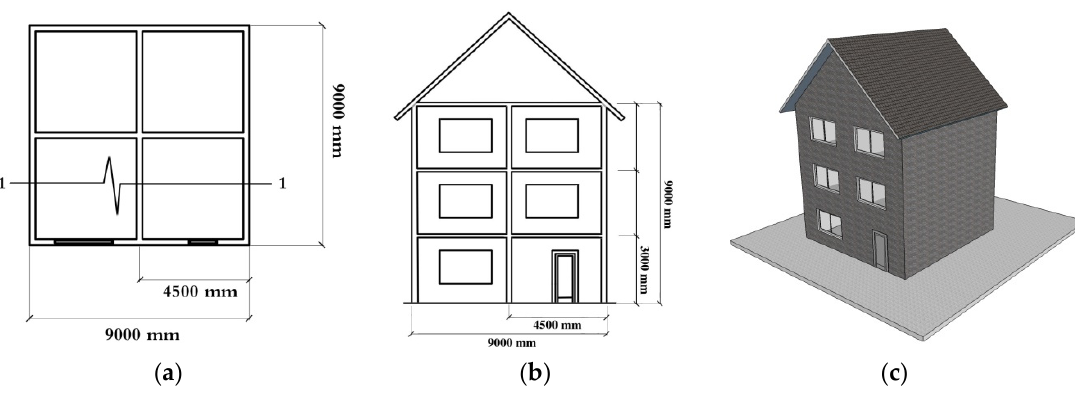
Figure 1. The prototype structure ( a ) a plan view; ( b ) an elevation view; ( c ) a 3D prototype